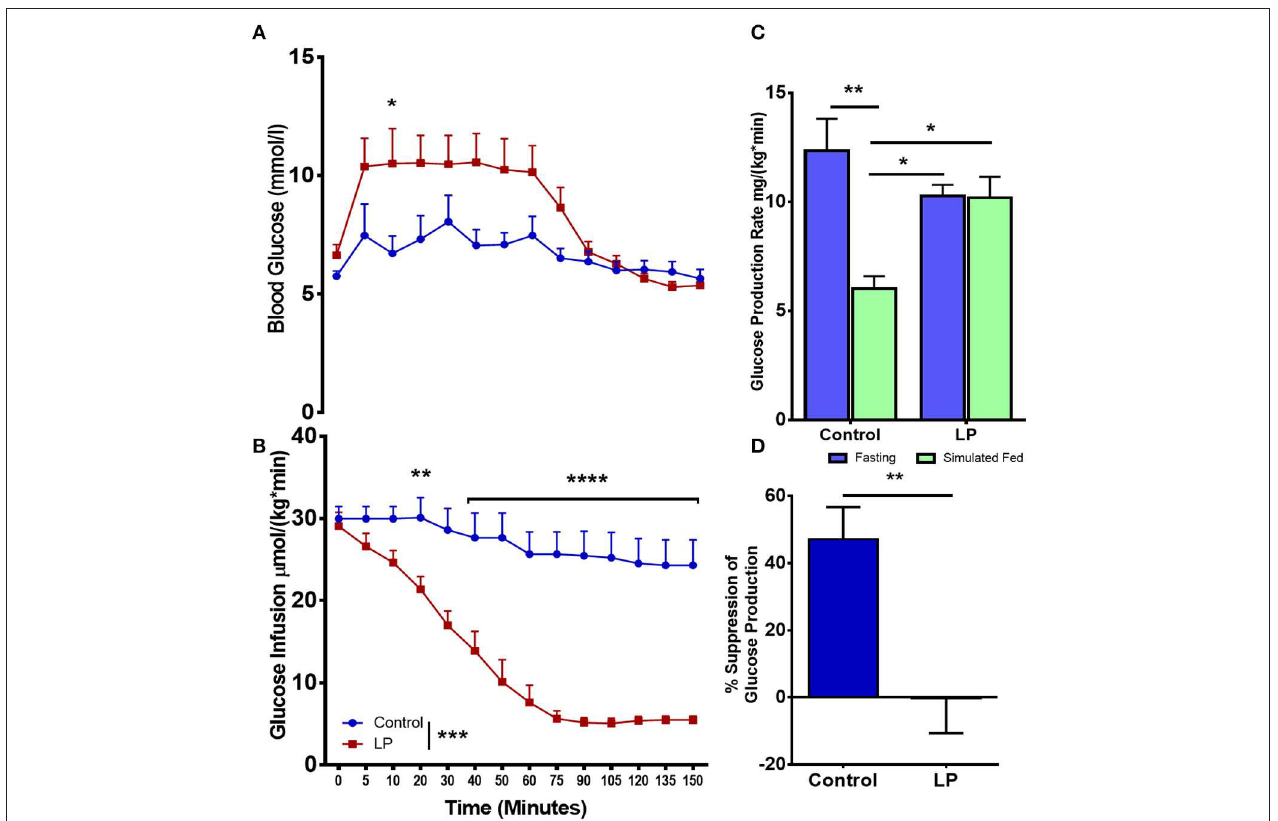
FIGURE 3 | Impaired insulin induced suppression of glucose production during fasting and simulated fed state from 6 month old low protein programmed lean type 2 diabetic (LP) female rats. (A,B) Euglycemic hyperinsulinemic clamp for type 2 diabetic (LP) females in comparison with controls. (C) Total hepatic glucose production rate during fasting and simulated fed state. (D) Percentage suppression of glucose production in males during simulated fed state. * p < 0.05, ** p < 0.01, *** p < 0.001, and **** p < 0.0001, n =